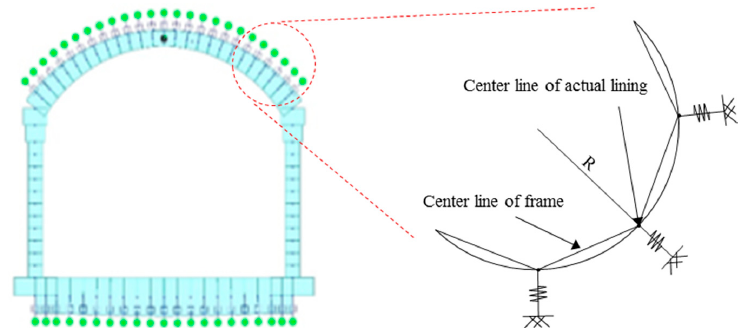
Figure 17. Structural analysis of the concrete lining of the central tunnel using the beam-spring model. The concrete lining was modeled as beam elements with an elastic modulus of 27.6 GPa and a